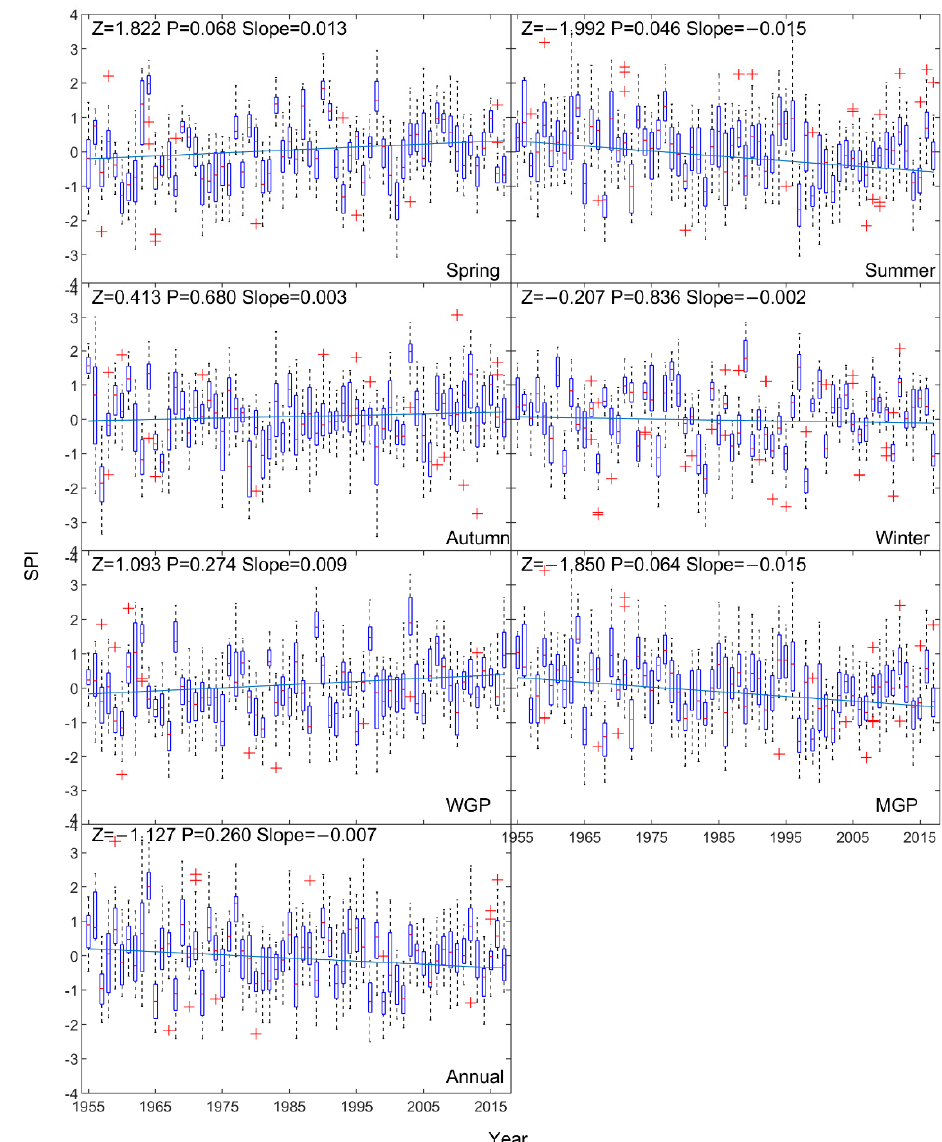
Figure 5. Boxplots of interannual SPI calculated for different time periods. For each box, the central mark indicates the median, and the bottom and top edges of the box indicate the 25th and 75th percentiles of 20 stations, respectively. The whiskers extend to the most extreme data points, and the outliers are plotted individually using the “+” symbol.